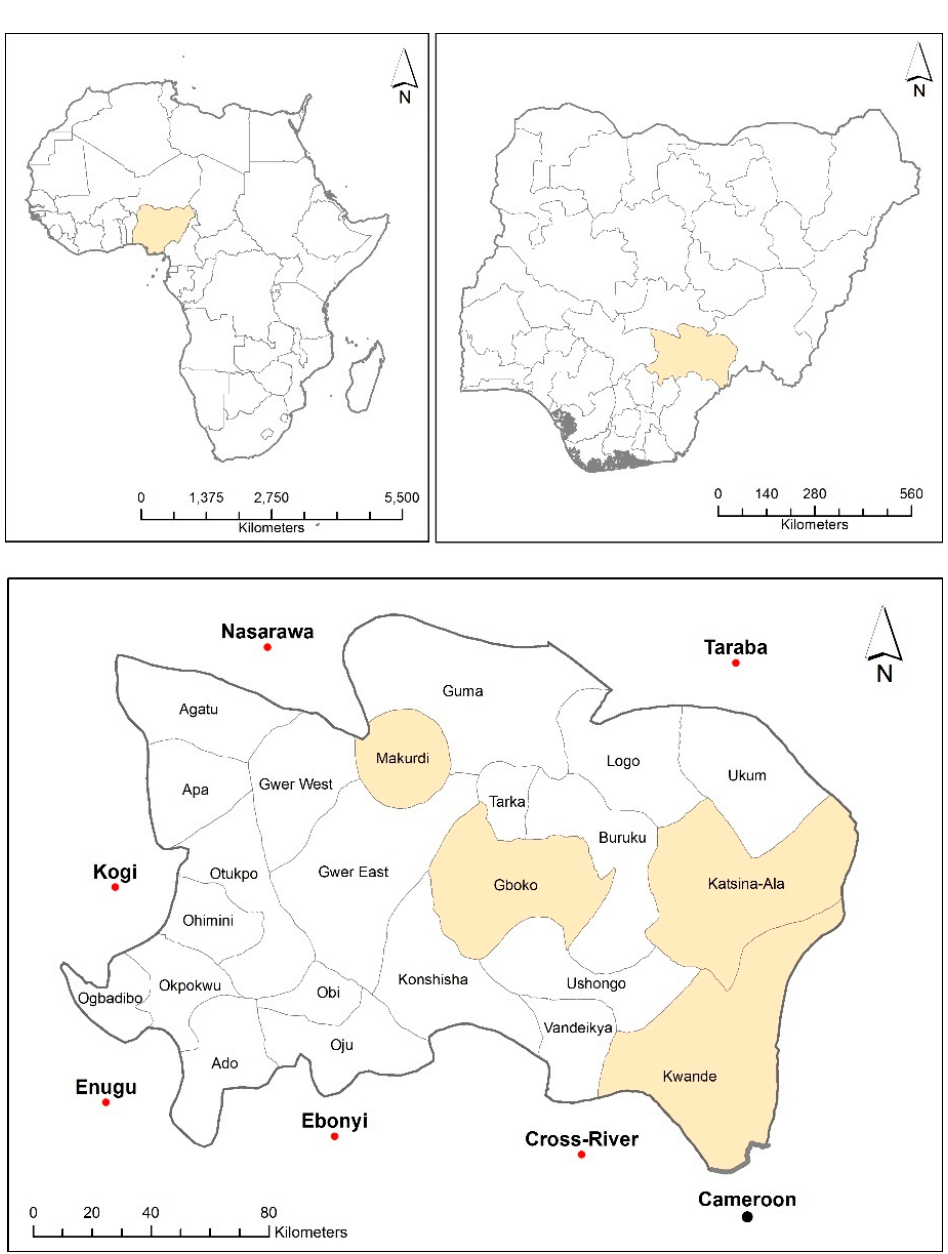
Figure 1. The upper left-hand map shows the location of Nigeria in Africa while the upper right-hand map shows the location of Benue state in Nigeria. Coordinates: longitude 7 ◦ 47 (cid:48) and 10 ◦ 0 (cid:48) E; Latitude 6 ◦ 25 (cid:48) and 8 ◦ 8 (cid:48) N. The shaded areas in the map of Benue are the four sampled local government areas (LGAs) situated within the two agricultural zones that constitute the most active farming zones in Benue state. (i.e., Benue north and Benue east zones). The unshaded areas are other LGAs in Benue not included in the